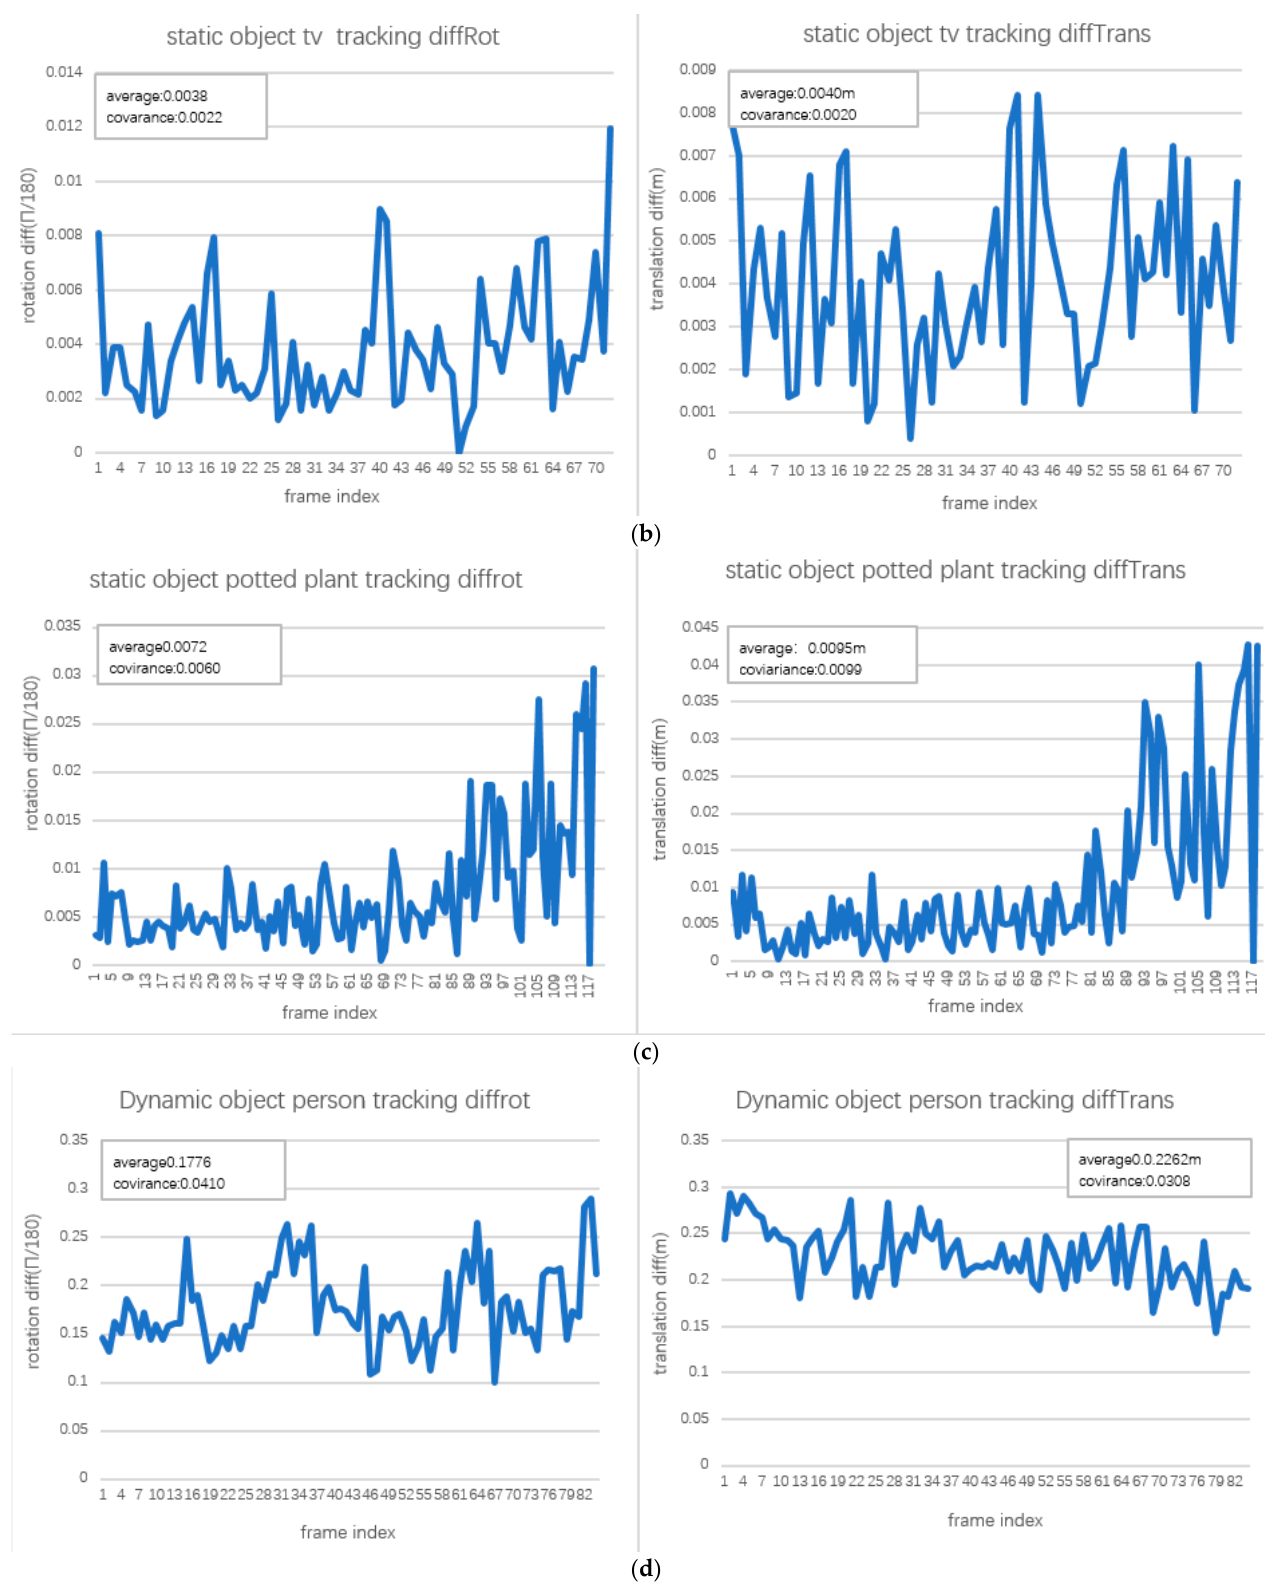
Figure 6. The different objects motion detection result against the current camera pose: ( a ) Static object dining table; ( b ) static object TV; ( c ) static object potted plant; ( d ) dynamic object pedestrian.